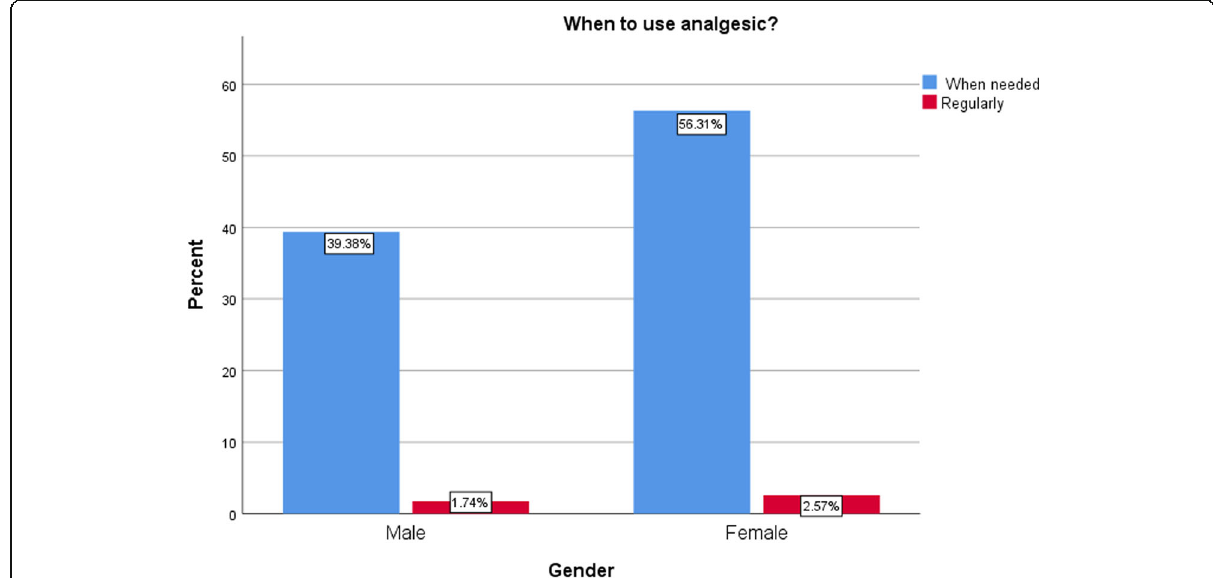
Fig. 1 The percentage of gender by when to use analgesics